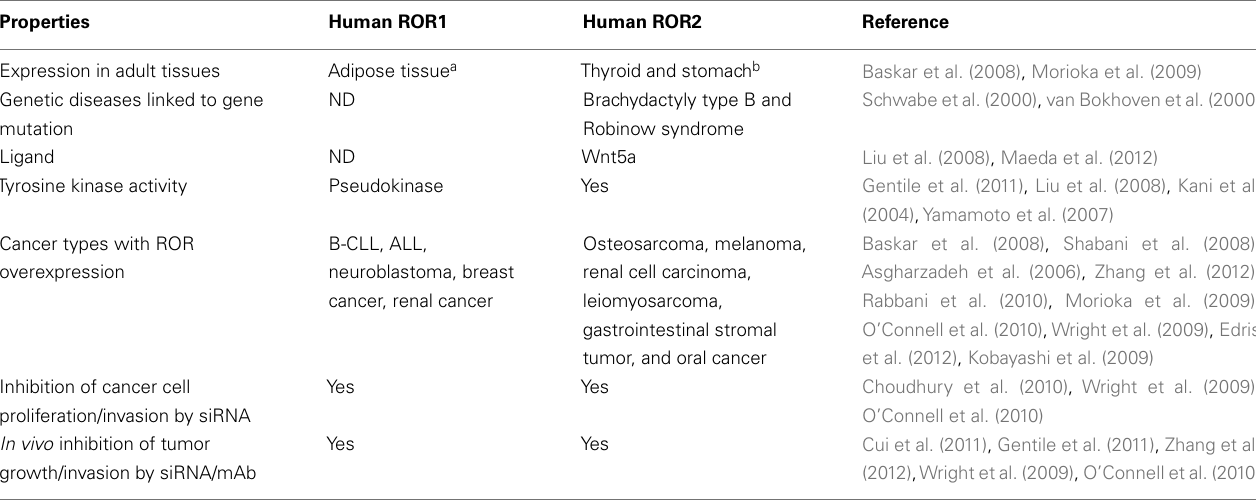
Table 1 | Summary of evidence for human ROR1/2 as cancer therapeutic